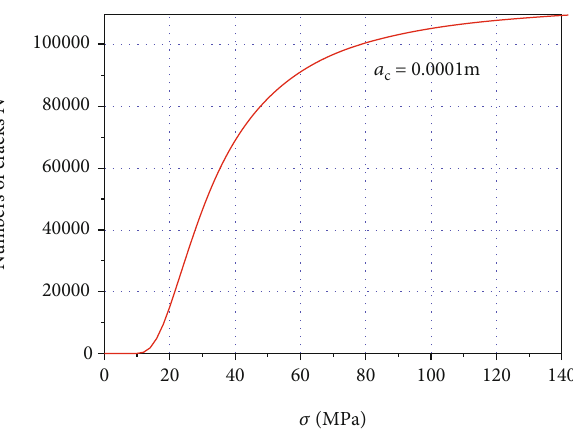
Figure 6: Relationship between the microcrack initiation number and axial stress.